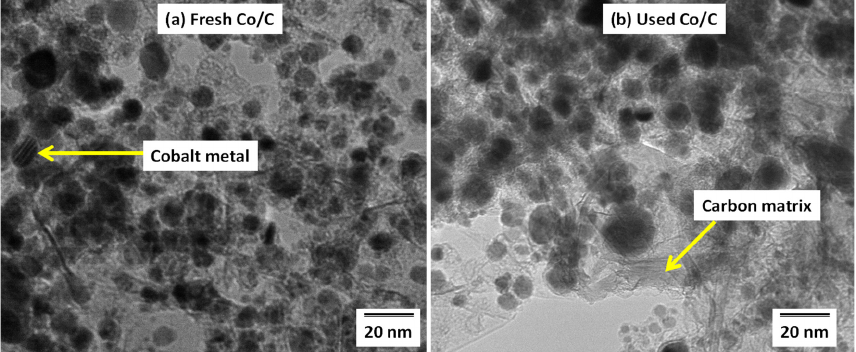
Figure 2. Transmission Electron Microscopic (TEM) images for the fresh and used plasma ‐ synthesized Co/C samples.